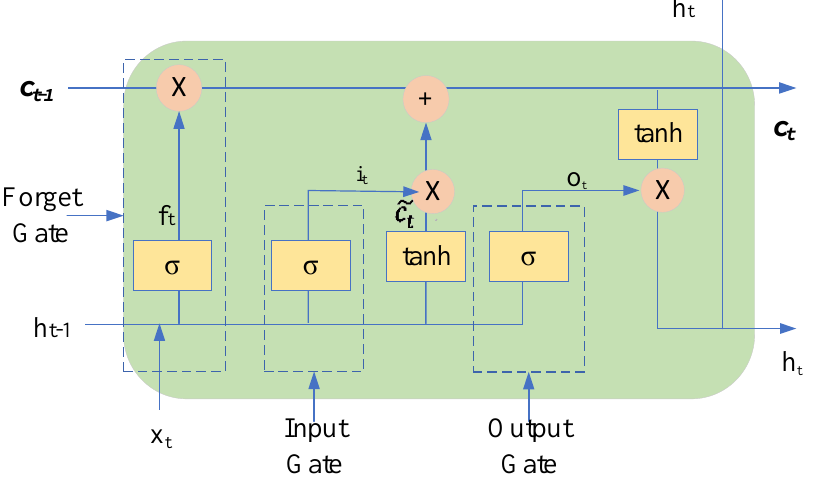
Figure 1. The structure of LSTM neurons.